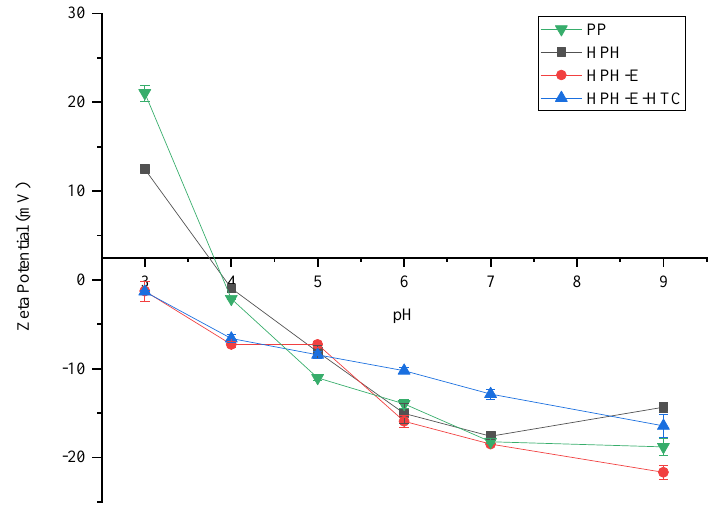
Figure 6. Zeta potential ( ζ ) profiles of peanut protein (PP), high pressure homogenized protein (HPH), high pressure homogenized and enzyme treated protein (HPH-E), and HPH-E-hydrothermally cooked (HPH-E-HTC) protein as a function of pH at 25 °C.